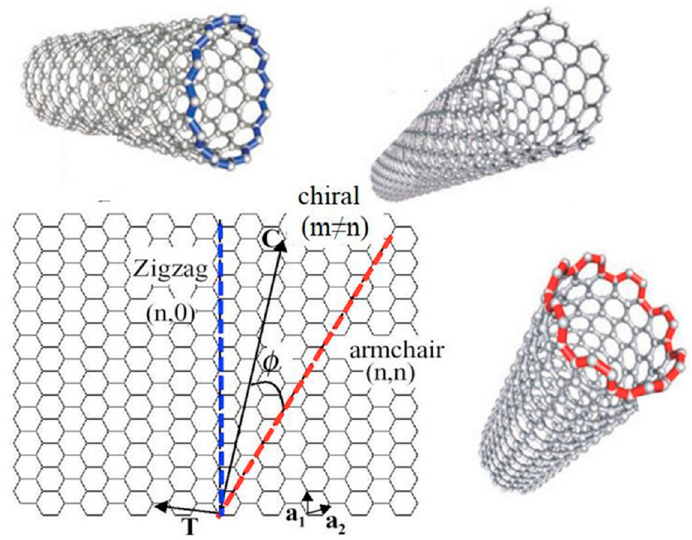
Figure 2. Diagram showing the various possible rolling directions of graphene that results in single wall carbon nanotubes with different chiralities [14].